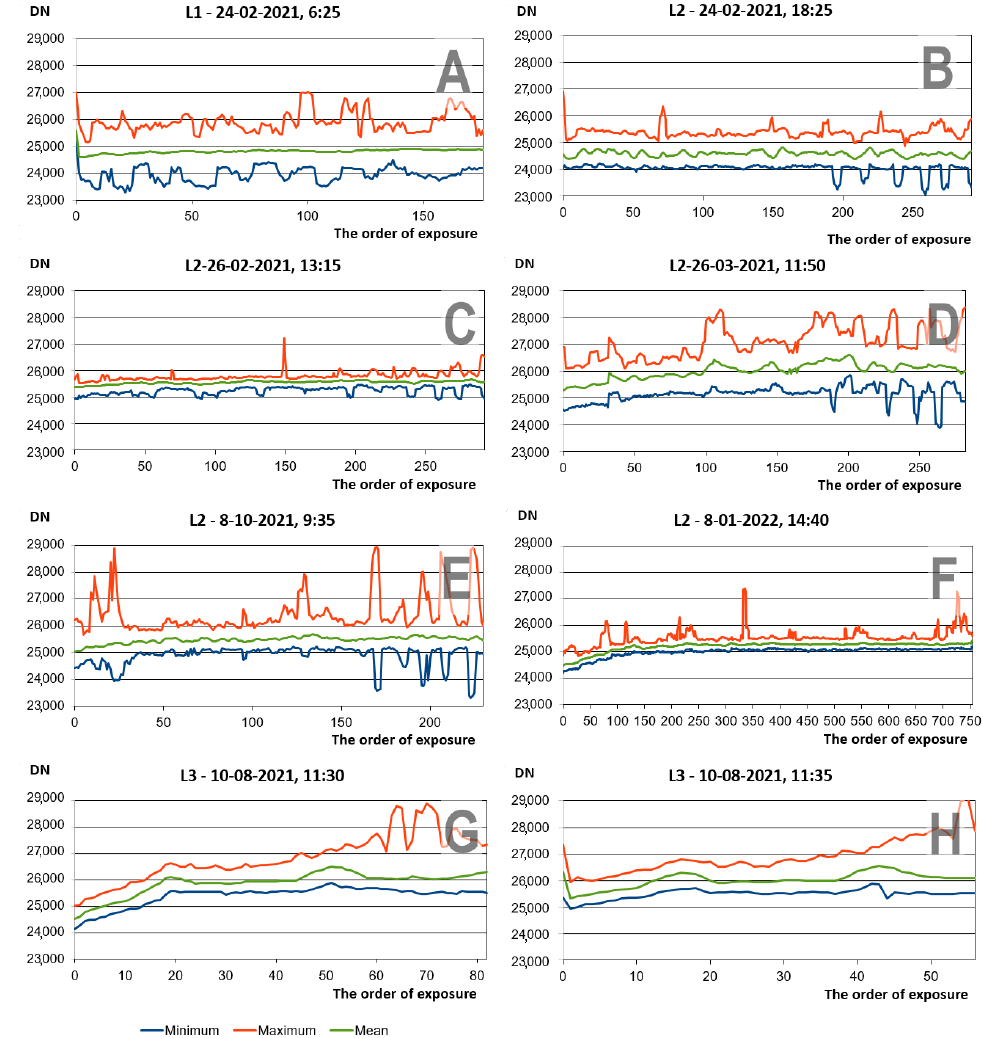
Figure 7. Graphs showing statistical parameters of sets including average, minimum and maximum values, of consecutive photos in individual sets according to the order of taking. The markings of the subsequent ( A – H ) charts correspond to the photo set identifiers used in Figures 5 and 6.